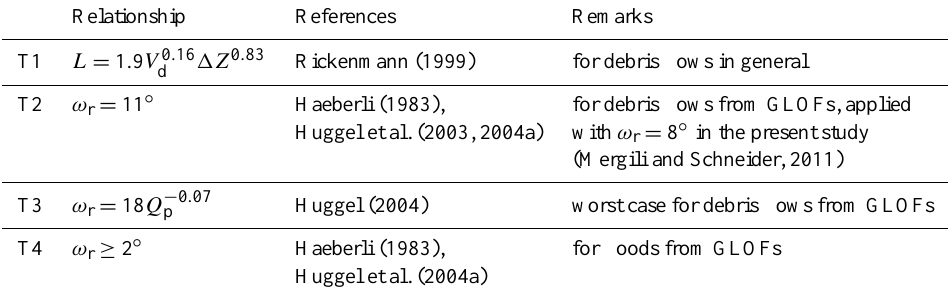
Table 8. Empirical relationships used for estimating the travel distance of lake outburst floods. GLOF – glacial lake outburst flood, L – travel